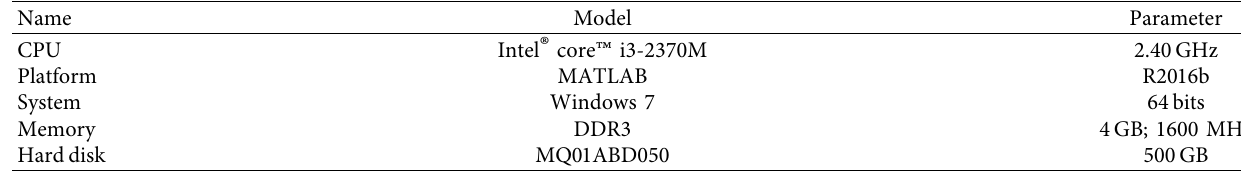
Table 4: Specific information about the operating environment.